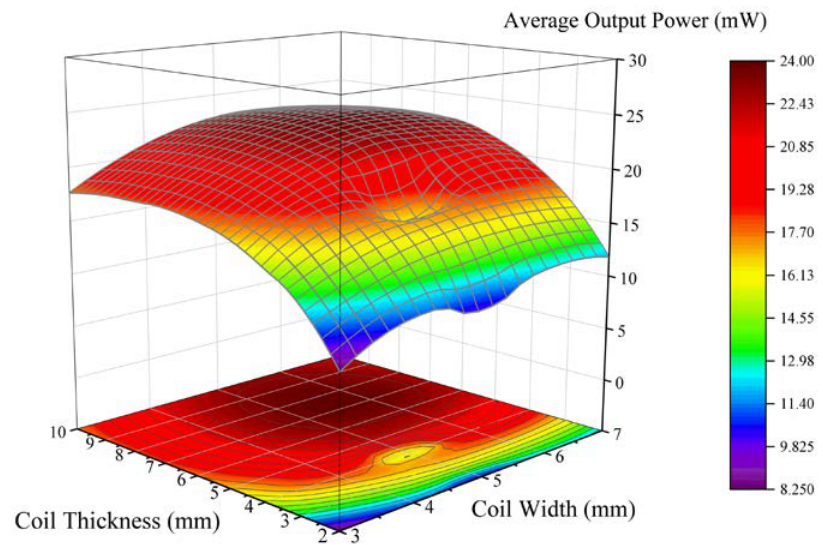
Figure 3. Output power of the energy harvester under different combines of coil width and thickness.